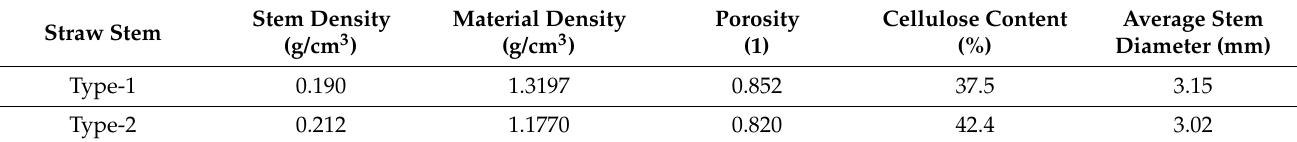
Table 1. Measured physical properties of the investigated straw